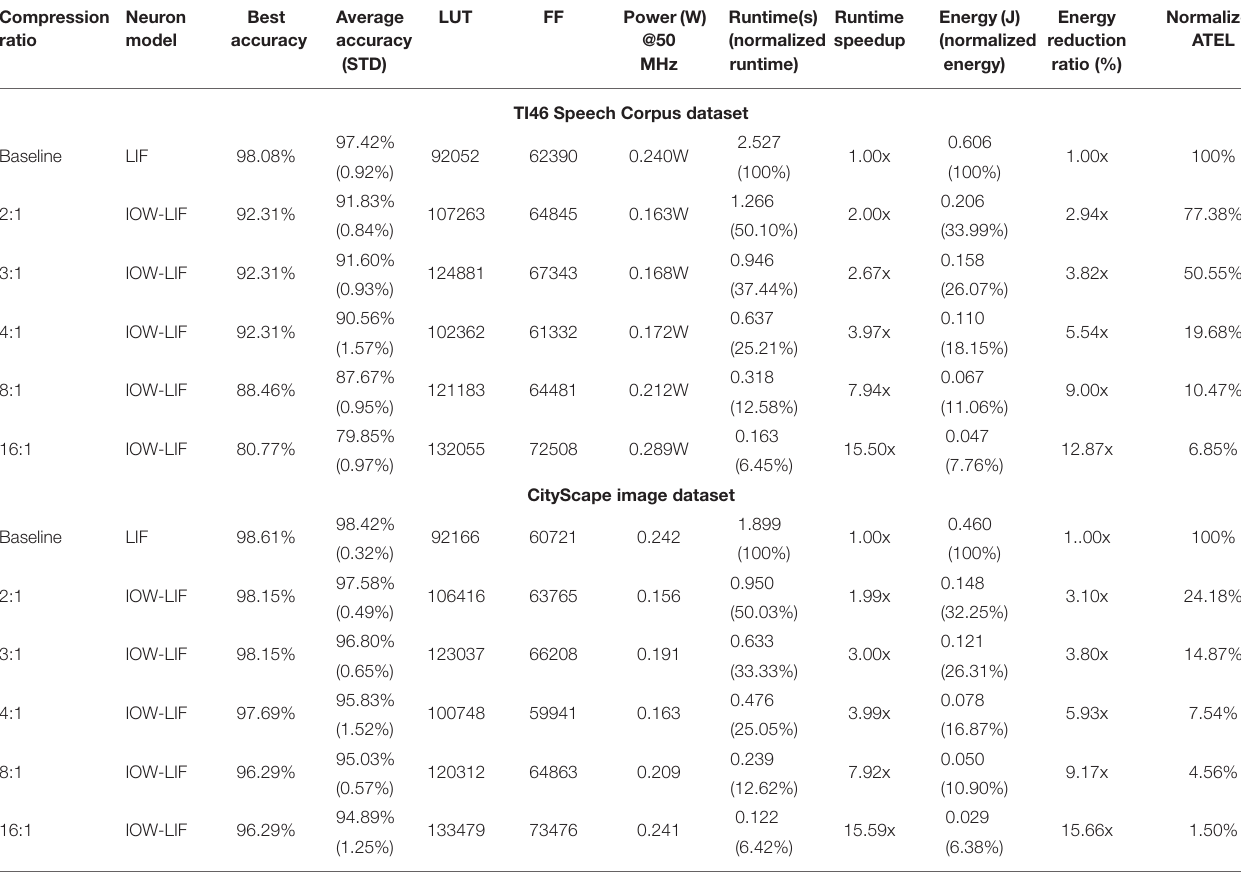
TABLE 3 | Comparison of the baseline and TC-SNN accelerators with burst coding on the TI46 Speech Corpus and on CityScape image dataset. Compression Neuron ratio model